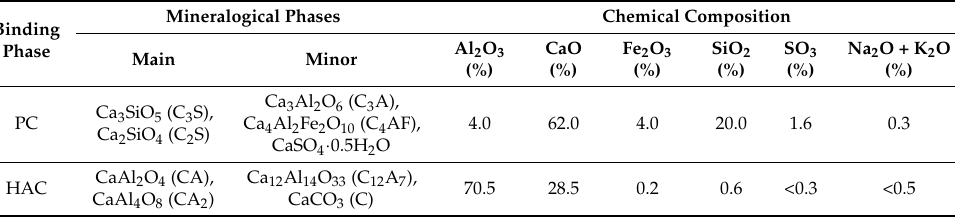
Table 1. Chemical and mineralogical compositions of the raw cementing